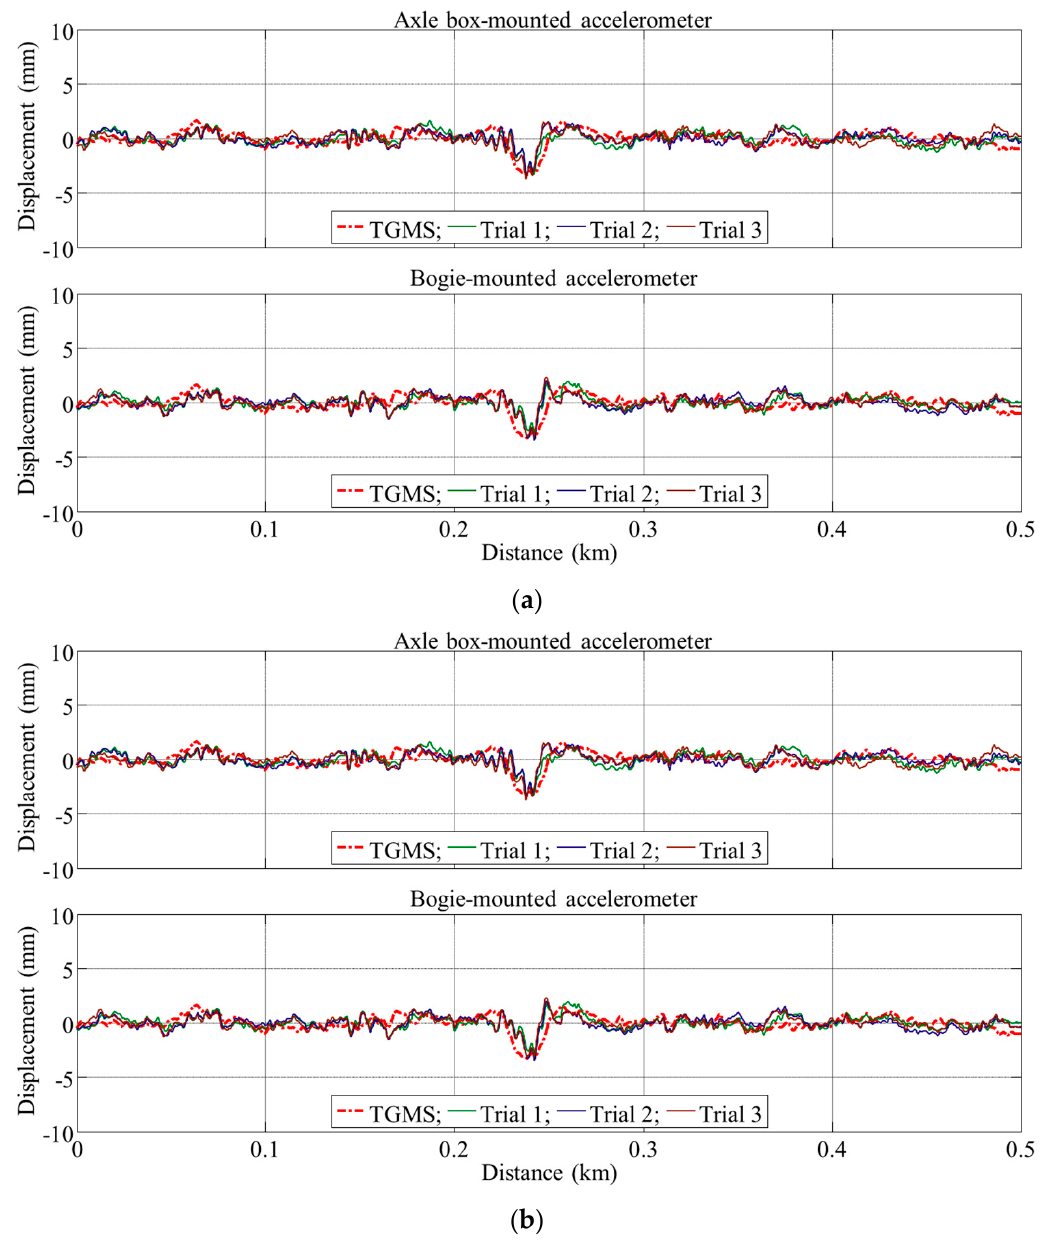
Figure 11. Estimation of track irregularities in the spatial domain: ( a ) lateral direction; ( b ) vertical direction.